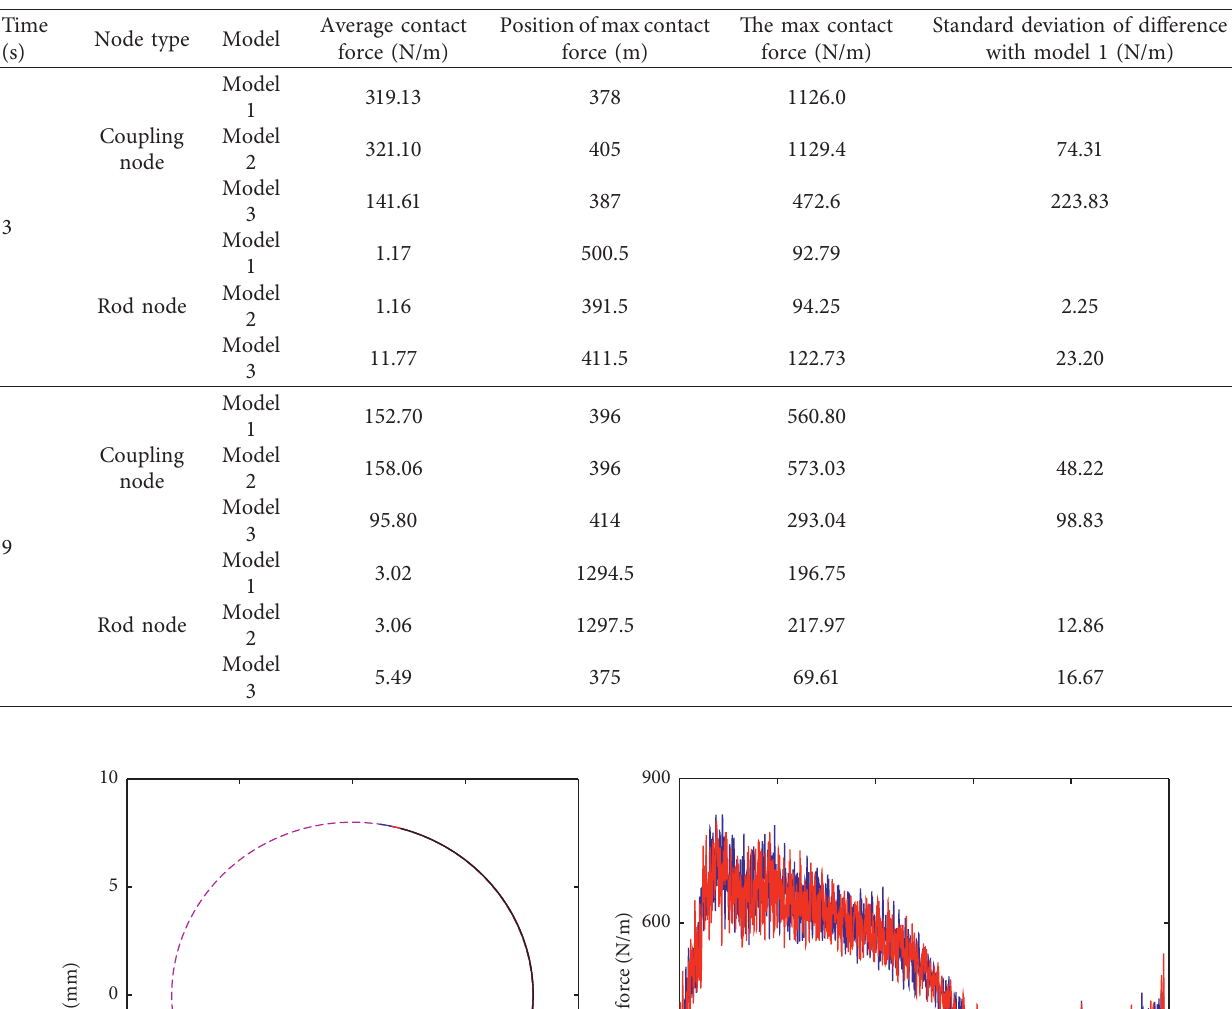
Table 3: Statistical table of rod-tube contact force characteristic values at 3s and 9s.